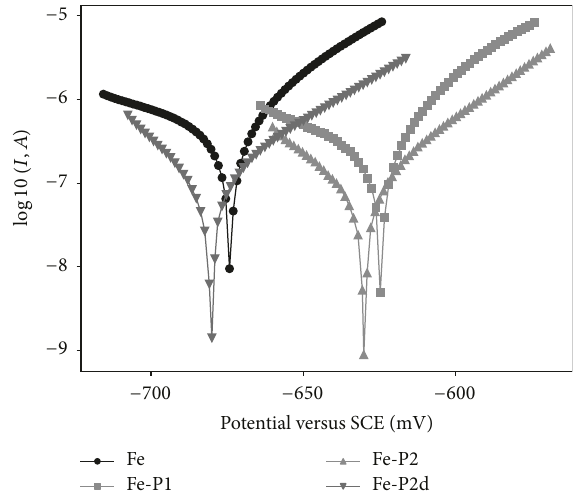
Figure 4: Polarization curves for pure Fe covered with PANI dispersions at 8th day of keeping in 3.5%